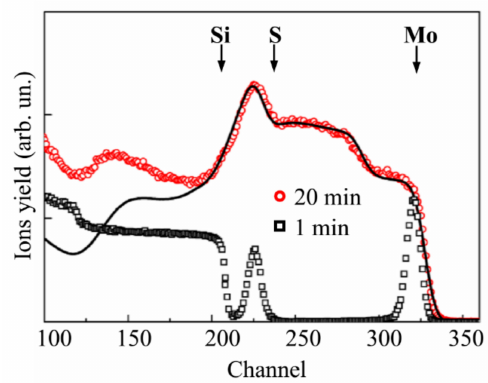
Figure 7. RBS spectra for MoS x ~3 + δ films obtained by o ff -axis PLD on the Si / SiO 2 substrates in Ar at a pressure of 8 Pa for 1 and 20 min. The solid lines indicate the model / fitted RBS spectrum for the corresponding experimental